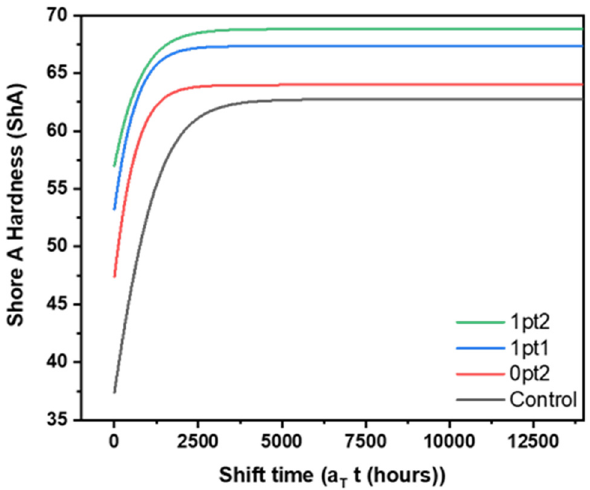
Figure 10. Time – temperature superposition master curve models of Shore A Hardness for the four thermal accelerated aged Sylgard 184